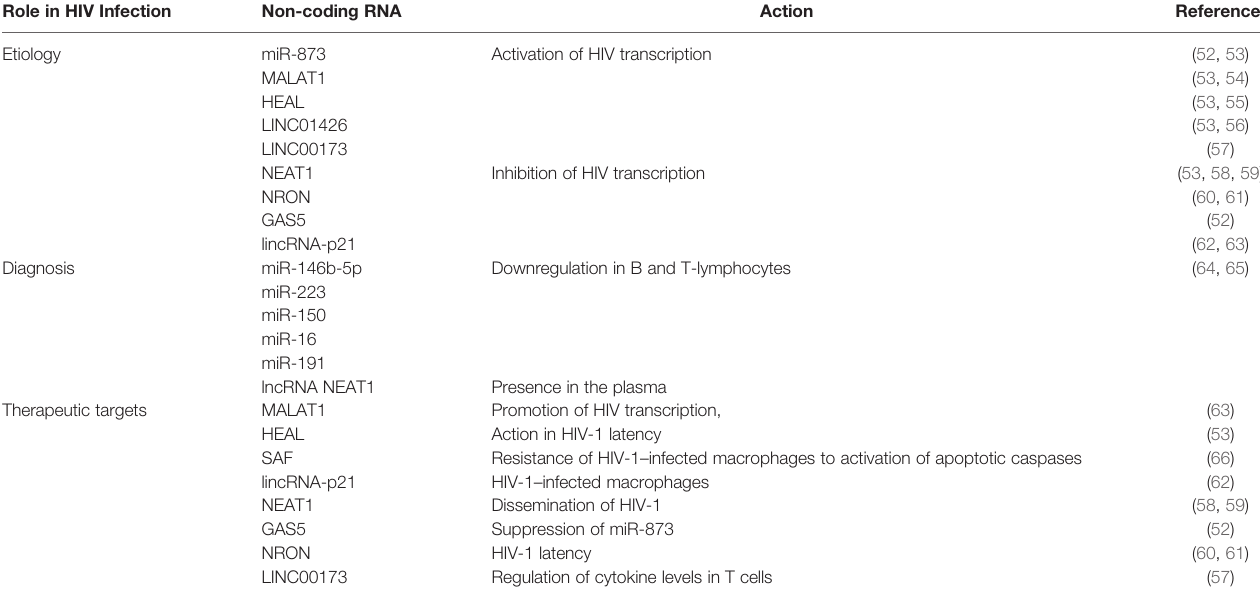
TABLE 2 | Non-coding RNAs in the etiology and control of HIV/AIDS. Role in HIV